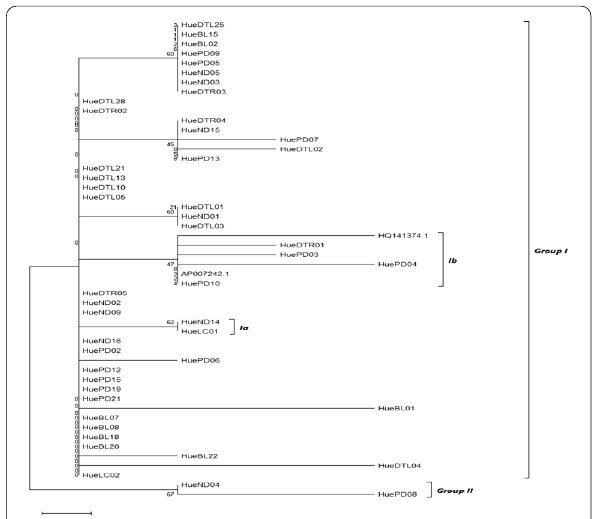
Fig. 3 Maximum likelihood phylogenetic tree based on the COI nucleotide sequences using the Tamura-Nei model (Tamura and Nei 1993)